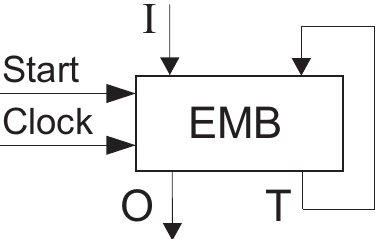
Figure 18. A trivial embedded memory block (EMB)-based circuit of Mealy FSM.